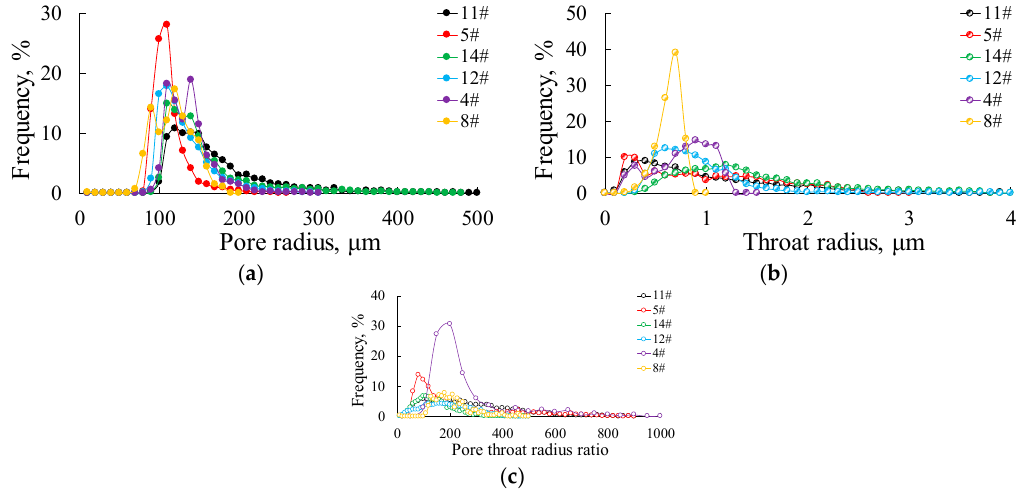
Figure 7. Pore-throat size distribution by RCMI of typical tight sandstones specimens: ( a ) pore size distribution; ( b ) throat size distribution; ( c ) pore throat radius ratio distribution.